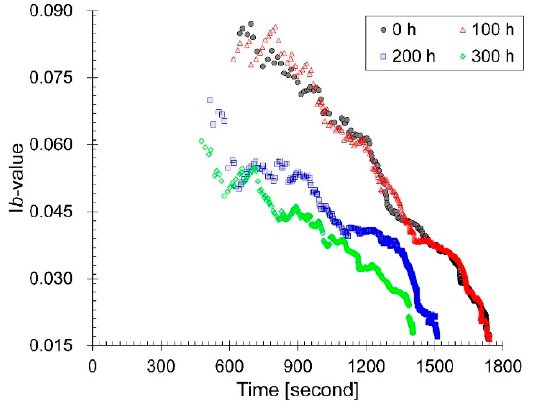
Figure 10. I b -values of specimens.